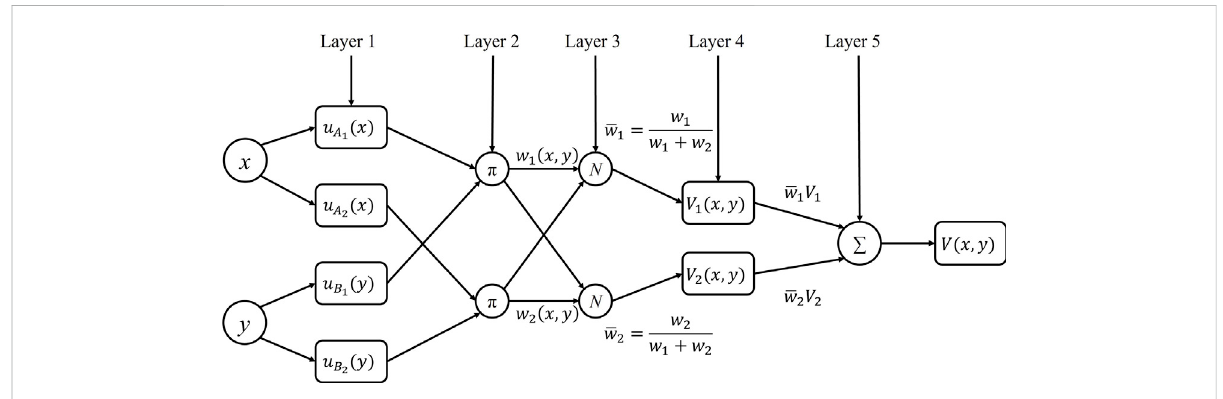
FIGURE 4 The architecture of